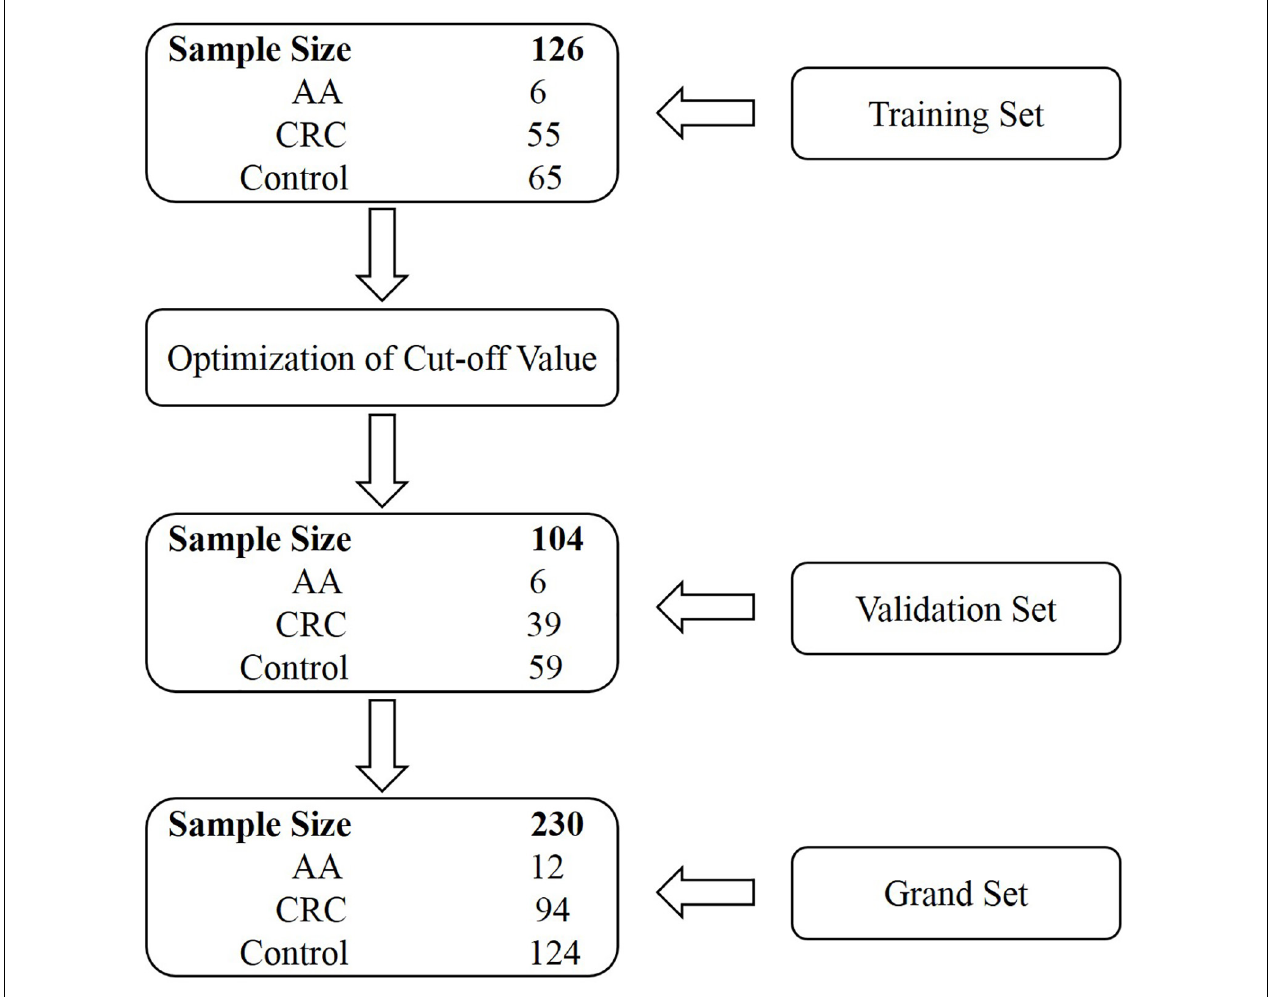
FIGURE 1 | Schematic representation of the study